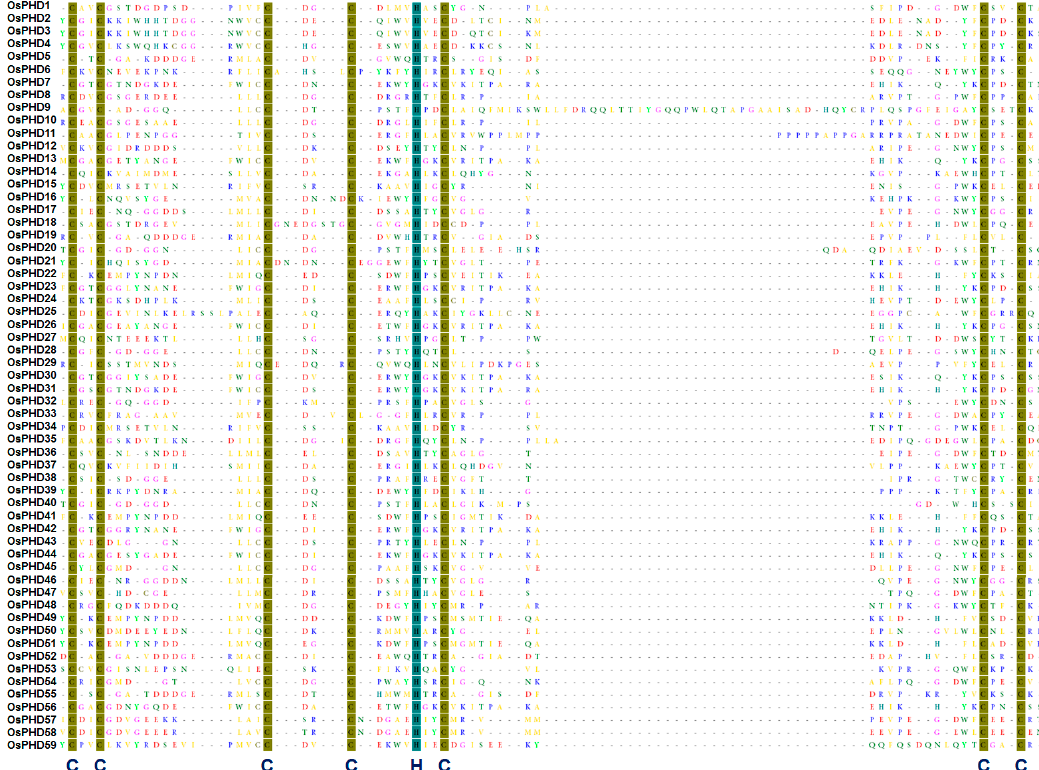
Figure 1. Protein sequence multiple alignment of the PHD-finger domains in the rice PHD family proteins. The multiple alignment was conducted with the amino acid sequences within the predicted PHD domains by using MEGA5.0 software with default parameters. The conserved amino acids (Cys4-His-Cys3) within the PHD-finger domains are shaded in brown and blue.